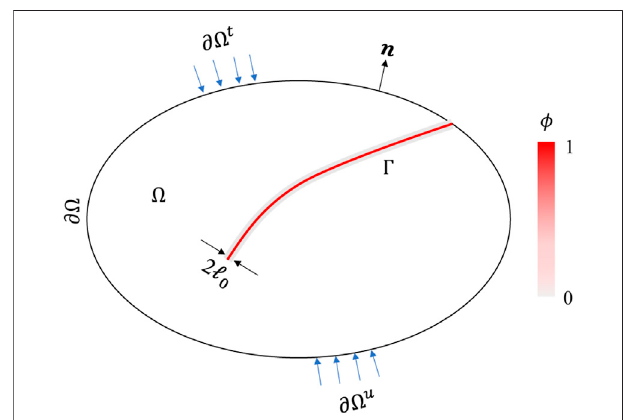
FIGURE 1 | Schematic diagram of diffusion characterization by the phase fi